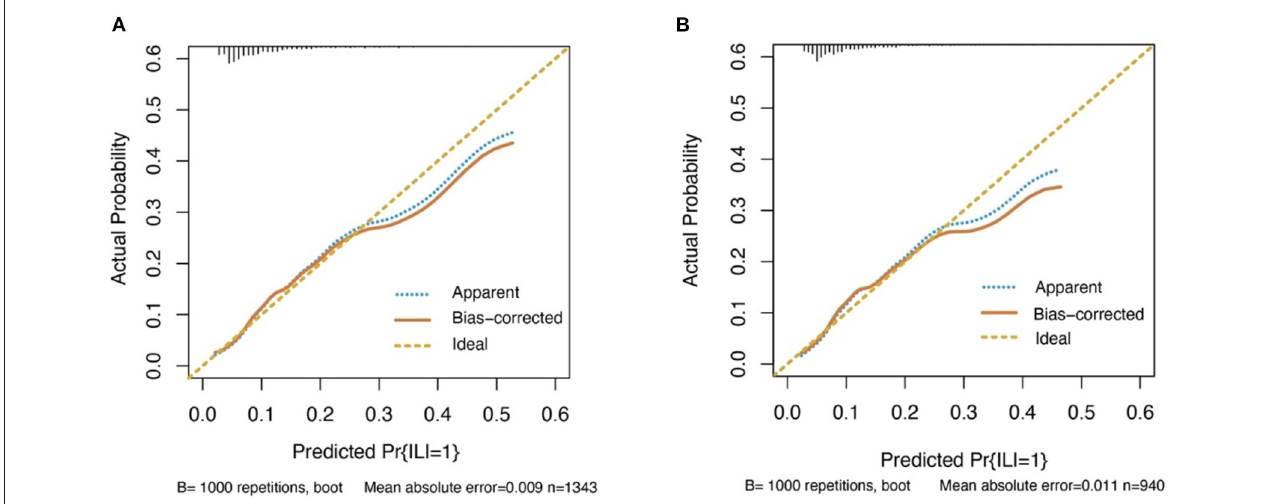
FIGURE 4 | Calibration curves for the prediction model in both cohorts. The curves describe the calibration of the nomogram in terms of agreement between predicted risks (x-axes) and actual outcomes (y-axes). The diagonal line indicates perfect prediction by an ideal model. The curve indicates the performance of the model. (A) Training cohort. (B) Validation